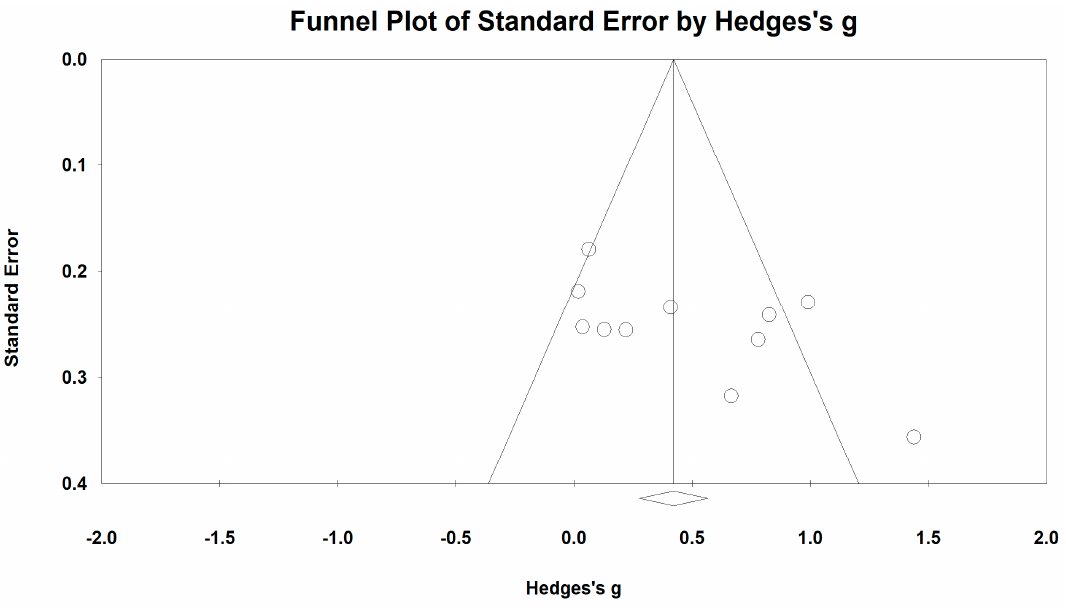
Figure 4. Funnel plot of publication for FEV 1 .